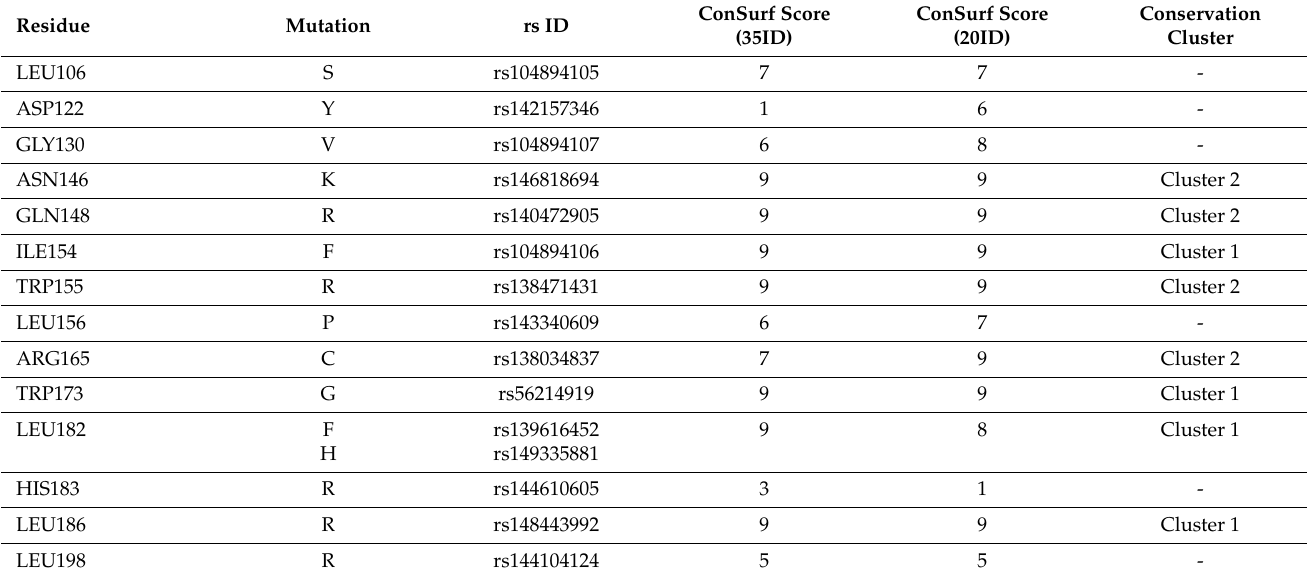
Table 3. ConSurf scores of Frataxin pathological point